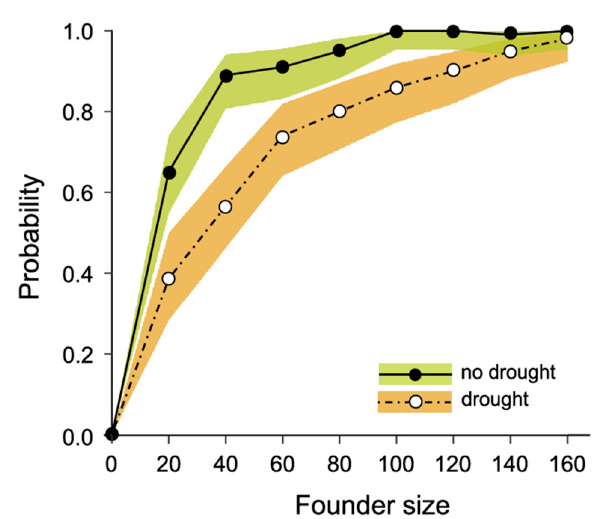
Figure 2. Probability of retaining a selectively neutral allele at a starting population frequency of 0.05 after 50 calendar years for translocated L. fasciatus populations with various founder sizes, with and without impacts of drought. Shaded ribbons represent 95% confidence intervals. Table 5. Viability of a translocated L. fasciatus population after 50 calendar years, testing four scenarios. One hundred individuals translocated in one or over two years, including a drought with a mean frequency of one every 6.25 calendar years. Carrying capacity was set at 10,000 and scenarios were run for 1000 replicates.